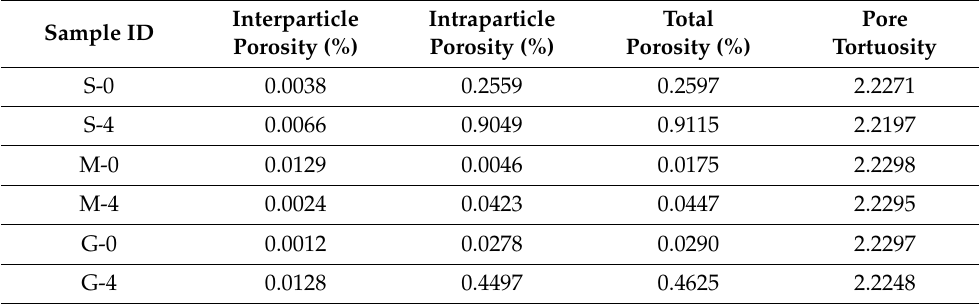
Table 2. Mercury intrusion pore sizing test.